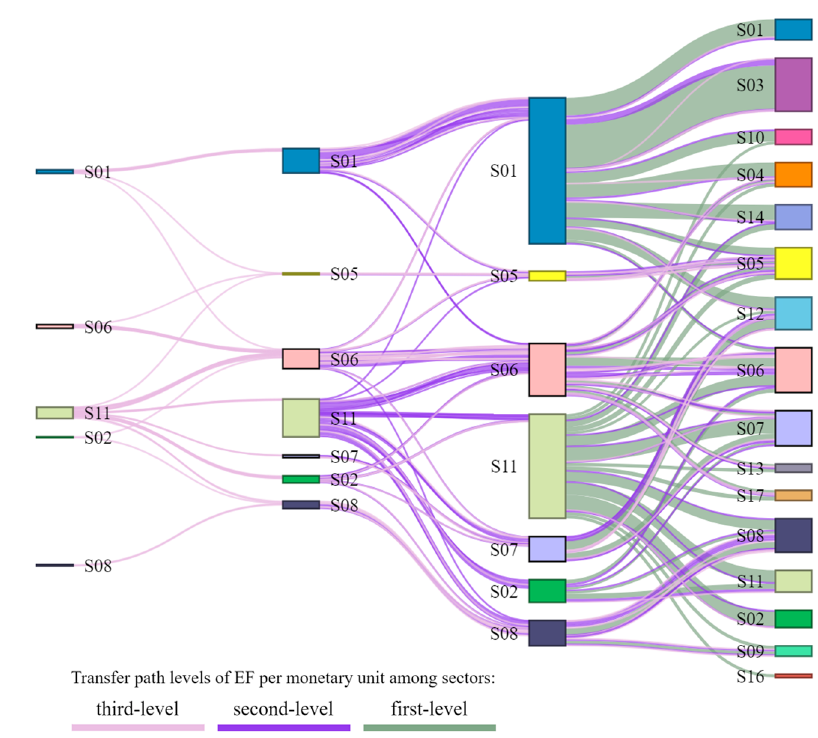
Figure 6. The key transfer paths of China’s EF per monetary unit among sectors in 2005.